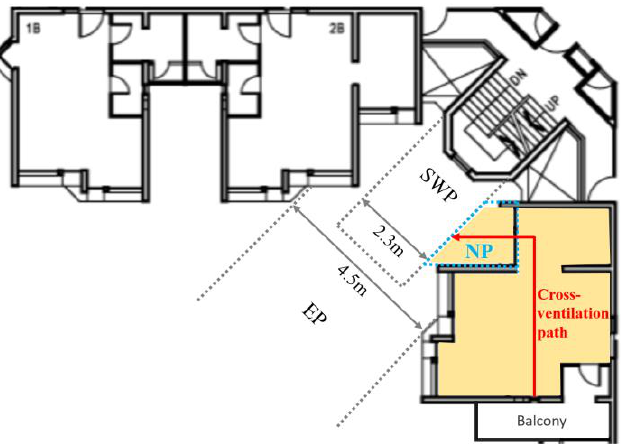
Figure A2. Schematics of the external plane, secondary window plane, and notional plane for buildings with concave surfaces.